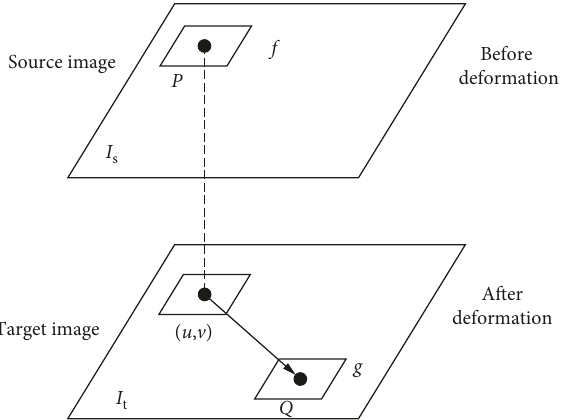
Figure 1: Schematic diagram of correlation image, representing the starting state, and I t is the target image, representing the state after deformation. If the